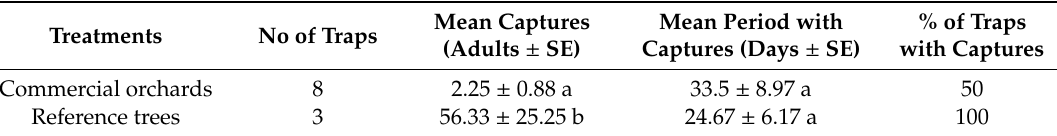
Mean Captures Mean Period with % of Traps (Adults ± SE) Captures (Days ± SE) with Captures